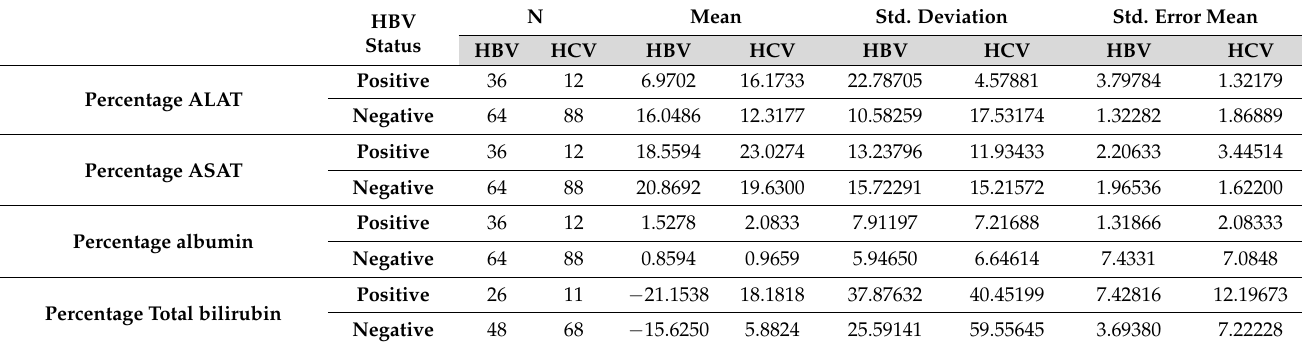
Table 7. Group statistic table for liver function in HIV/HBV and HIV/HCV co-infected and HIV mono-infected